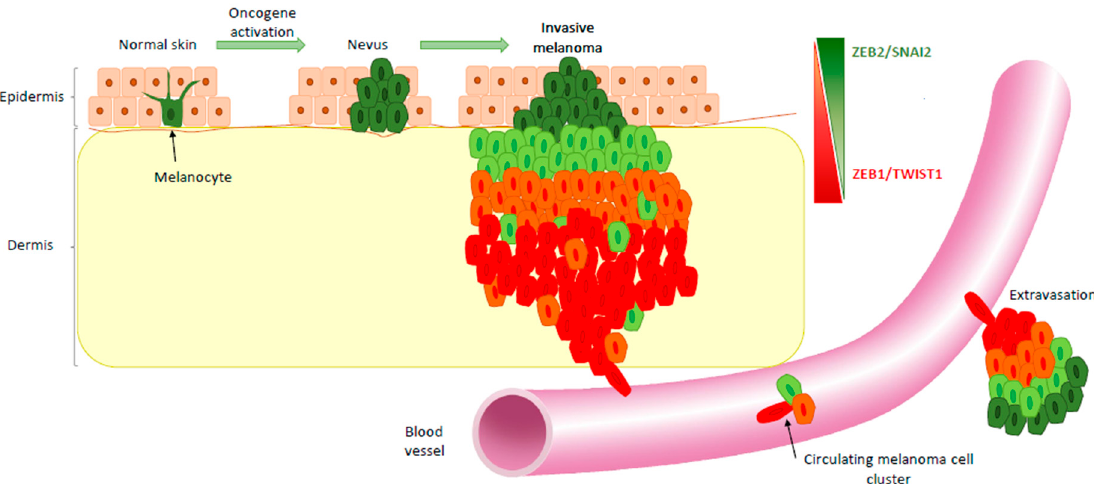
Figure 2. EMT-TF switch during melanoma development. ZEB2 and SNAIL2 are expressed in differentiated melanocytes within the epidermis of normal adult skin. Their expression is maintained in senescent benign nevi. During the conversion to primary melanoma, SNAIL2 and ZEB2 expression is progressively lost in favor of TWIST1 and ZEB1. Moreover, intra-tumoral heterogeneity of EMT-TFs is observed within melanoma lesions, the EMT-TF switch being generally observed as a gradient from upper part to deeper part of invasive melanoma. Gain of invasive capacity upon ZEB1 reactivation promotes melanoma cell entry into the bloodstream, with clusters of circulating melanoma cells, which may display di ff erent di ff erentiation expression patterns. The di ff erentiated pattern of EMT-TFs is reproduced in the secondary site following extravasation, allowing metastatic